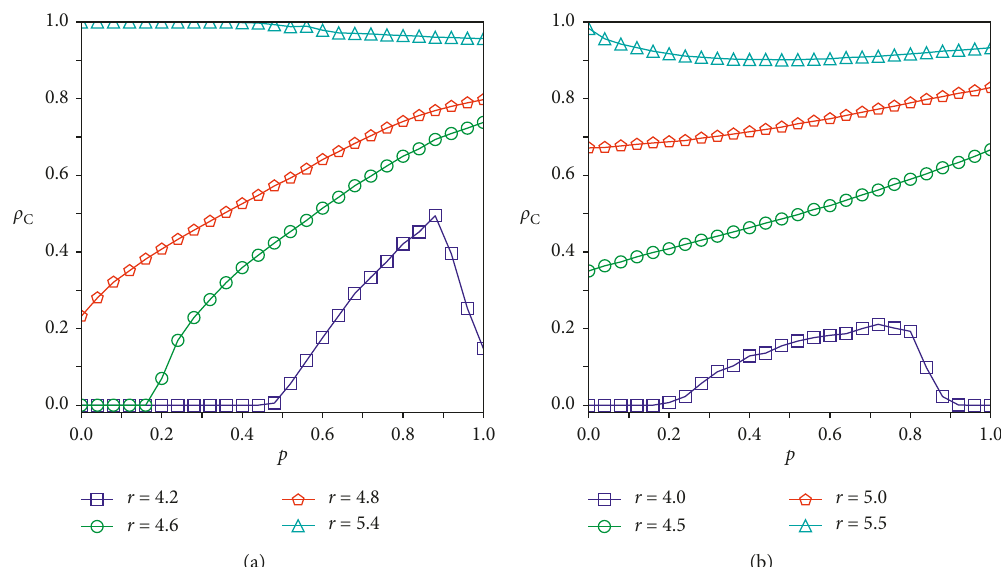
Figure 2: The cooperation level as functions of group density p for different enhancement levels of r on regular square lattice (a) and WS small-world network (b), respectively.